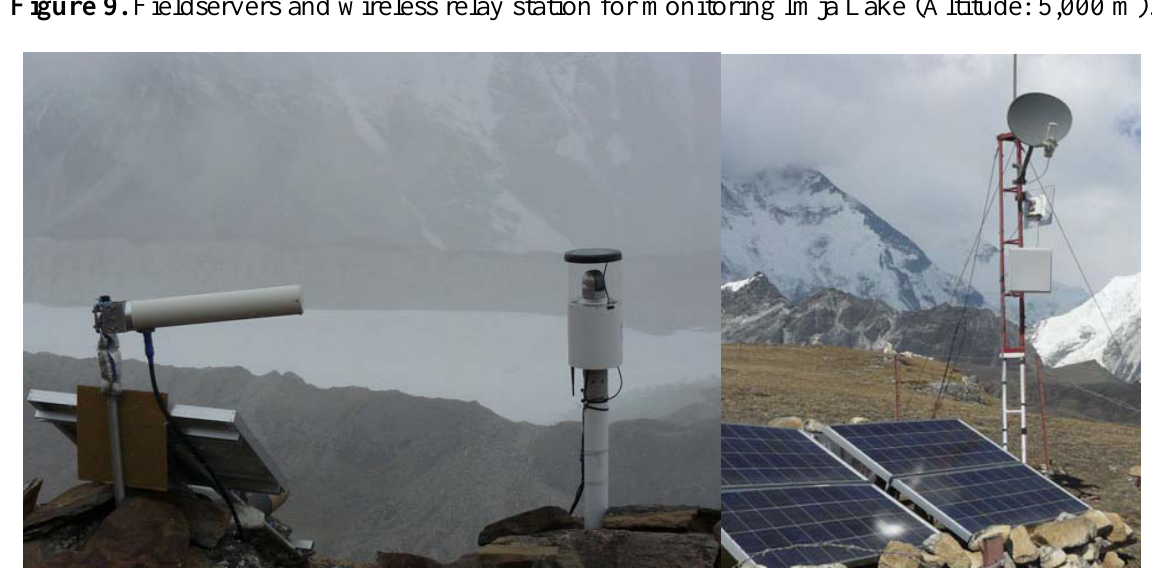
Figure 9. Fieldservers and wireless relay station for monitoring Imja Lake (Altitude: 5,000